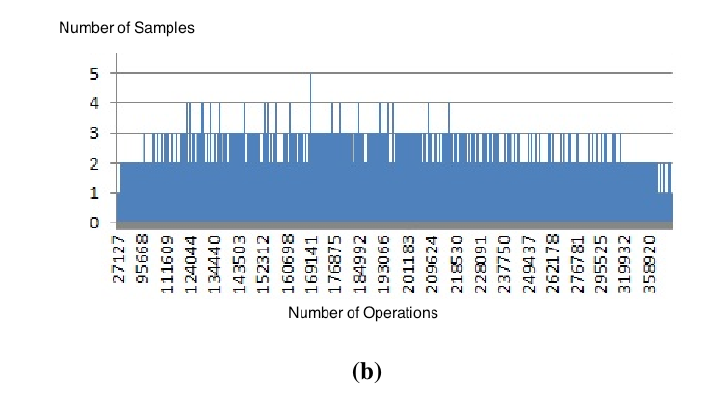
= 5 ). ( a ) Distribution found n